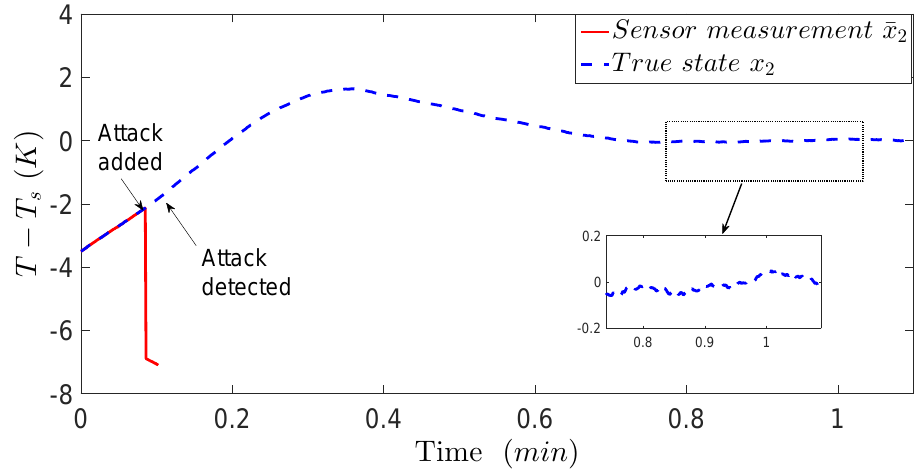
Figure 15. State profiles ( x 2 = T − T s , ¯ x 2 = ¯ T − T s ) for the closed-loop CSTR with bounded disturbances and the initial condition (0.25, − 3) under the LMPC of Equation (14) and the NN-based detection system.